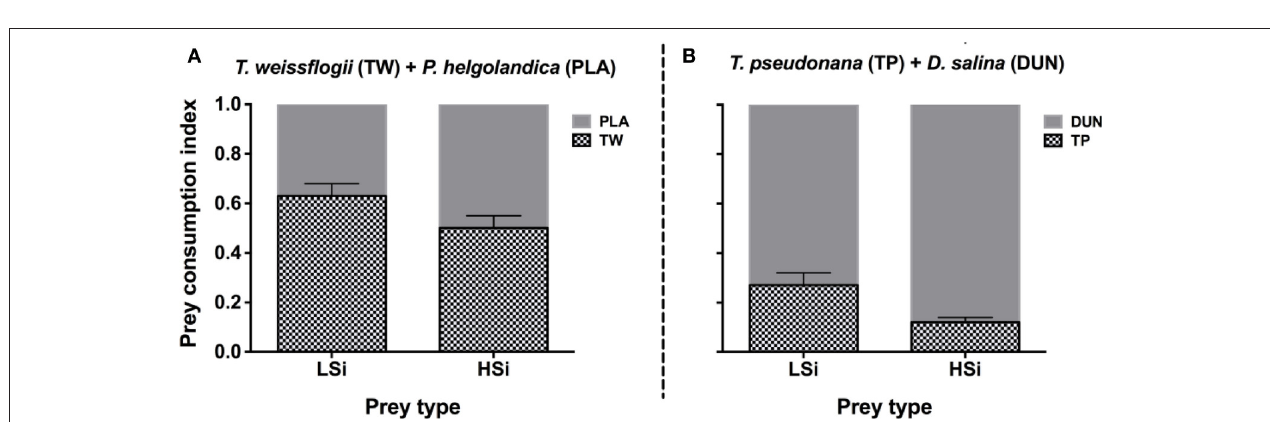
FIGURE 3 | Prey consumption index of Noctiluca scintillans on either T. weissflogii + P. helgolandica (A) , or T. pseudonana + D. salina (B) . LSi and HSi are low and high silica-containing diatom prey, respectively. Error bars indicate 1 SD ( n =